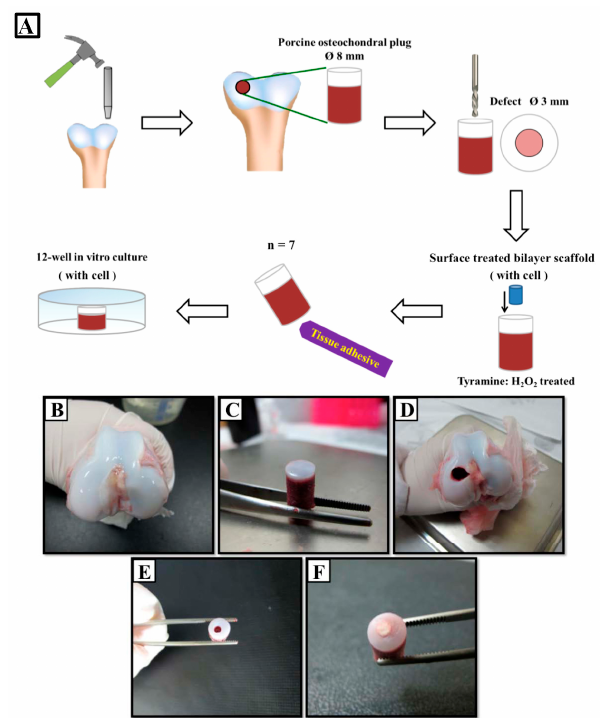
Figure 8. Fabrication of osteochondral host tissue plug and ex vivo co-culture of plug tissue and cell-seeded surface-treated scaffold. ( A ) Schematic illustration of porcine plug manufacture and co-culture of plug tissue and cell-seeded, surface-treated scaffold. Thick white arrows indicate the processes of osteochondral plug manufacture and the cell-seeded surface-treated scaffold implantation; thin black arrow indicates the implantation of cell-seeded surface-treated scaffold in porcine plug; the blue cylinder indicates the cell-seeded surface-treated scaffold. ( B ) Femoral condyles of porcine knee joints. ( C ) An osteochondral tissue plug was created using an eight-mm diameter hole driller. ( D ) Porcine femur after plug removal. ( E ) A three-mm defect was drilled into the osteochondral plug. ( F ) A three-mm cell-seeded bilayered PLGA scaffold was pressed into the defect.